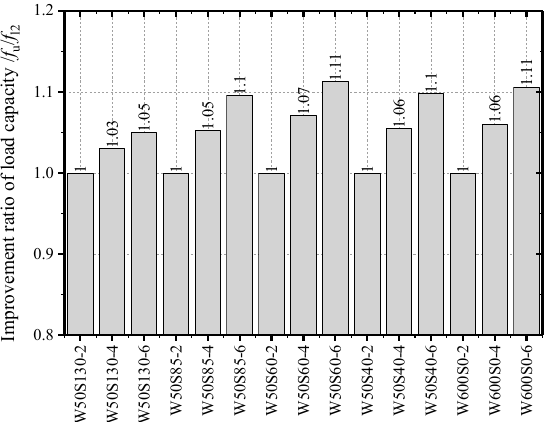
Figure 12. Improvement ratio of the externally wrapped GFRP layers to the peak carrying capacity.